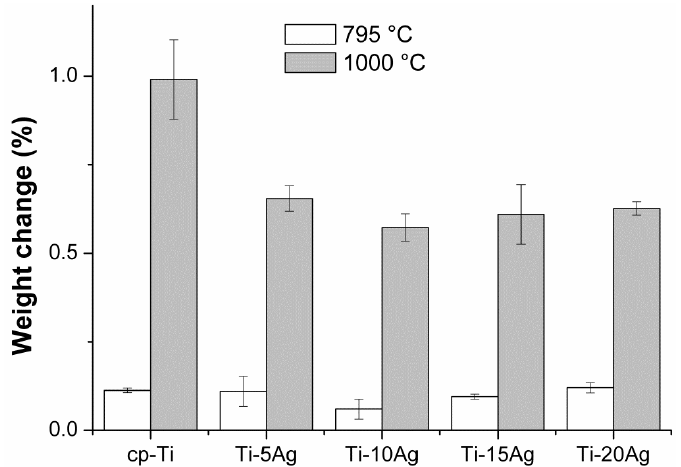
Figure 7. Thermogravimetric analysis (TGA) of cp-Ti and Ti– x Ag alloys showing various degrees of weight gain (%) by heating in air up to 795 °C and 1000